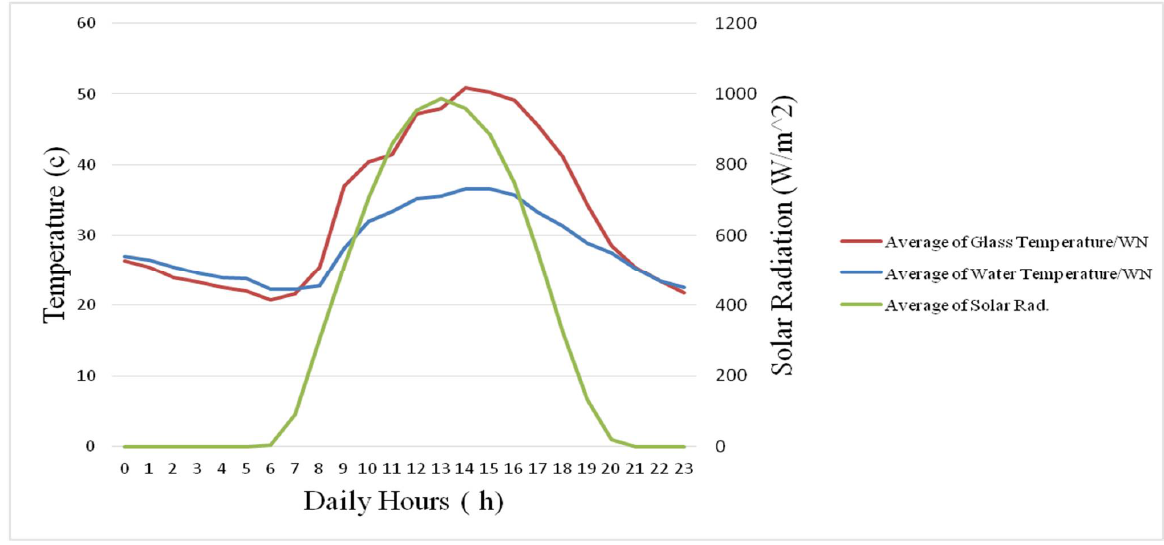
Figure 6. Hourly solar radiation and glass and water temperatures for 0.4% concentration.